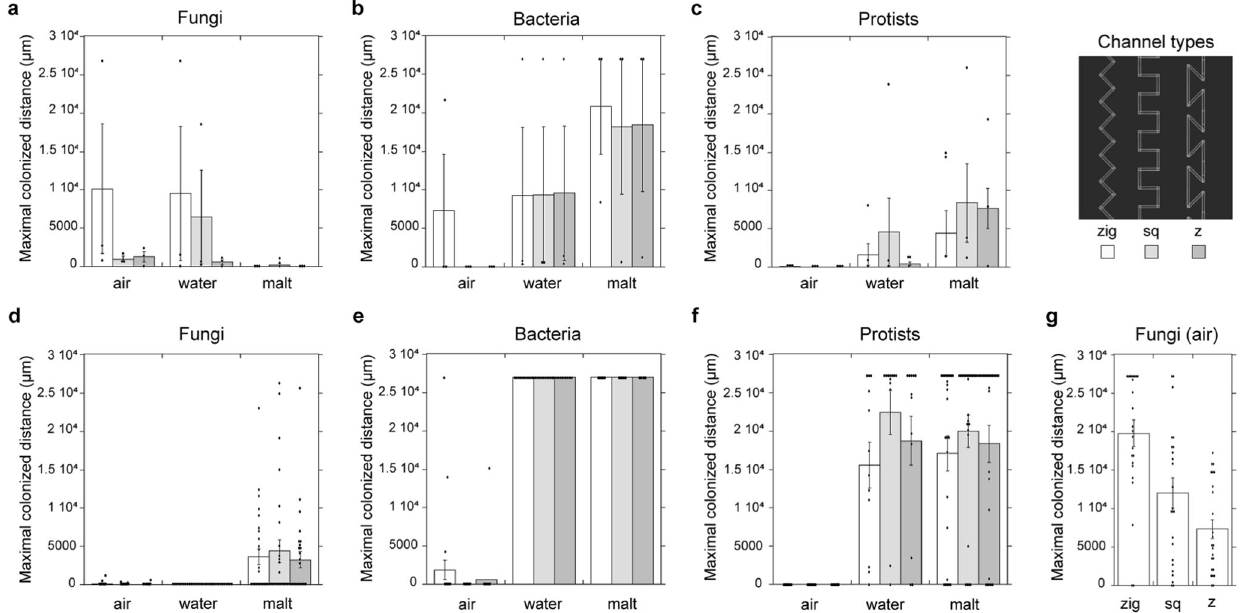
Fig. 2 Maximum dispersal extent of different soil microbial groups. Colonization distances of the three microbial groups, fungi, bacteria, and protists, recorded in soil chips incorporated into soil ( a , b , c , Expt. 1, n = 3 chips for each condition) and incubated with soil in the laboratory ( d , e , f , Expt. 2, n = 2 chips × 12 channels). g Fungal colonization distance in Expt. 3 (air- fi lled chips, n = 2 chips × 12 channels). The channels analysed are 10 µ m wide, shaped with corners of different angles (see legend: zigzag (white bars), square (light gray bars), z-shaped (dark gray bars), under the conditions dry = air- fi lled, water- fi lled, or malt extract- fi lled. Error bars denote the standard error of the mean; original data points overlaying. The maximum extent of the channels was 27,000 µ m and thus the maximum possible colonization extent of this